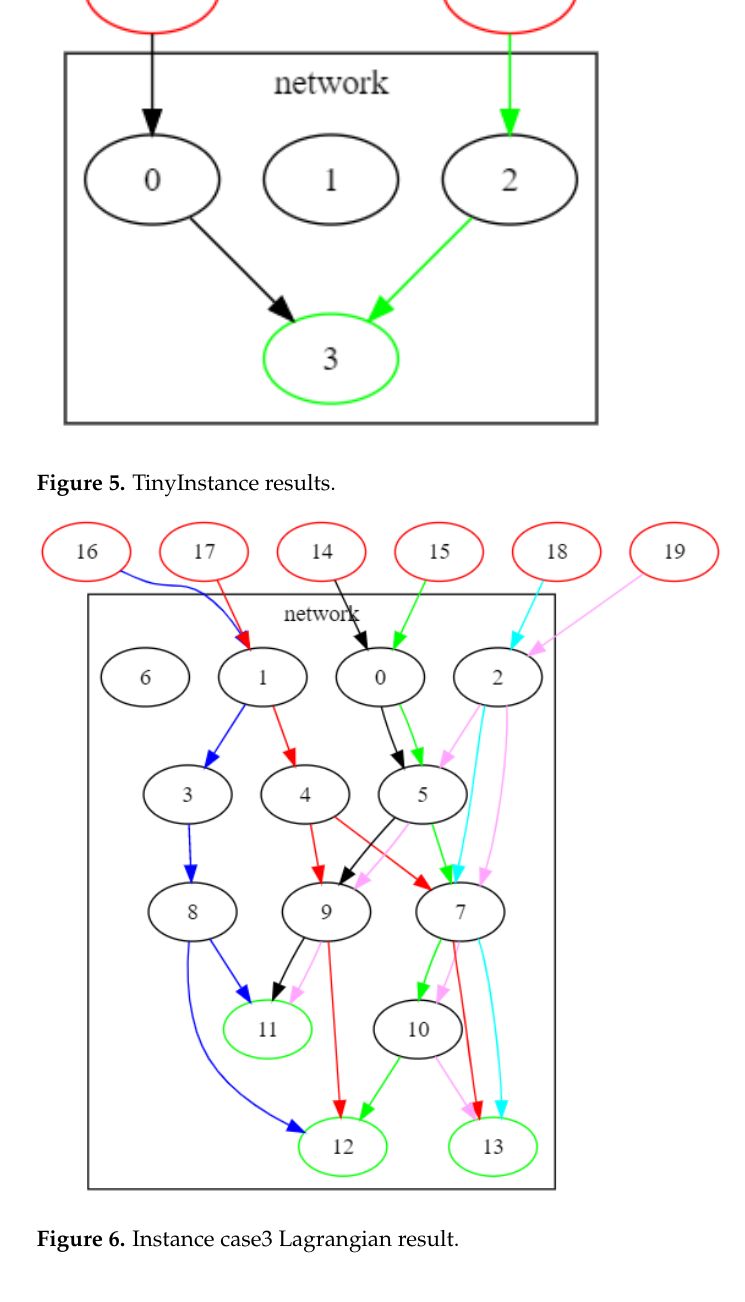
Figure 6. Instance case3 Lagrangian